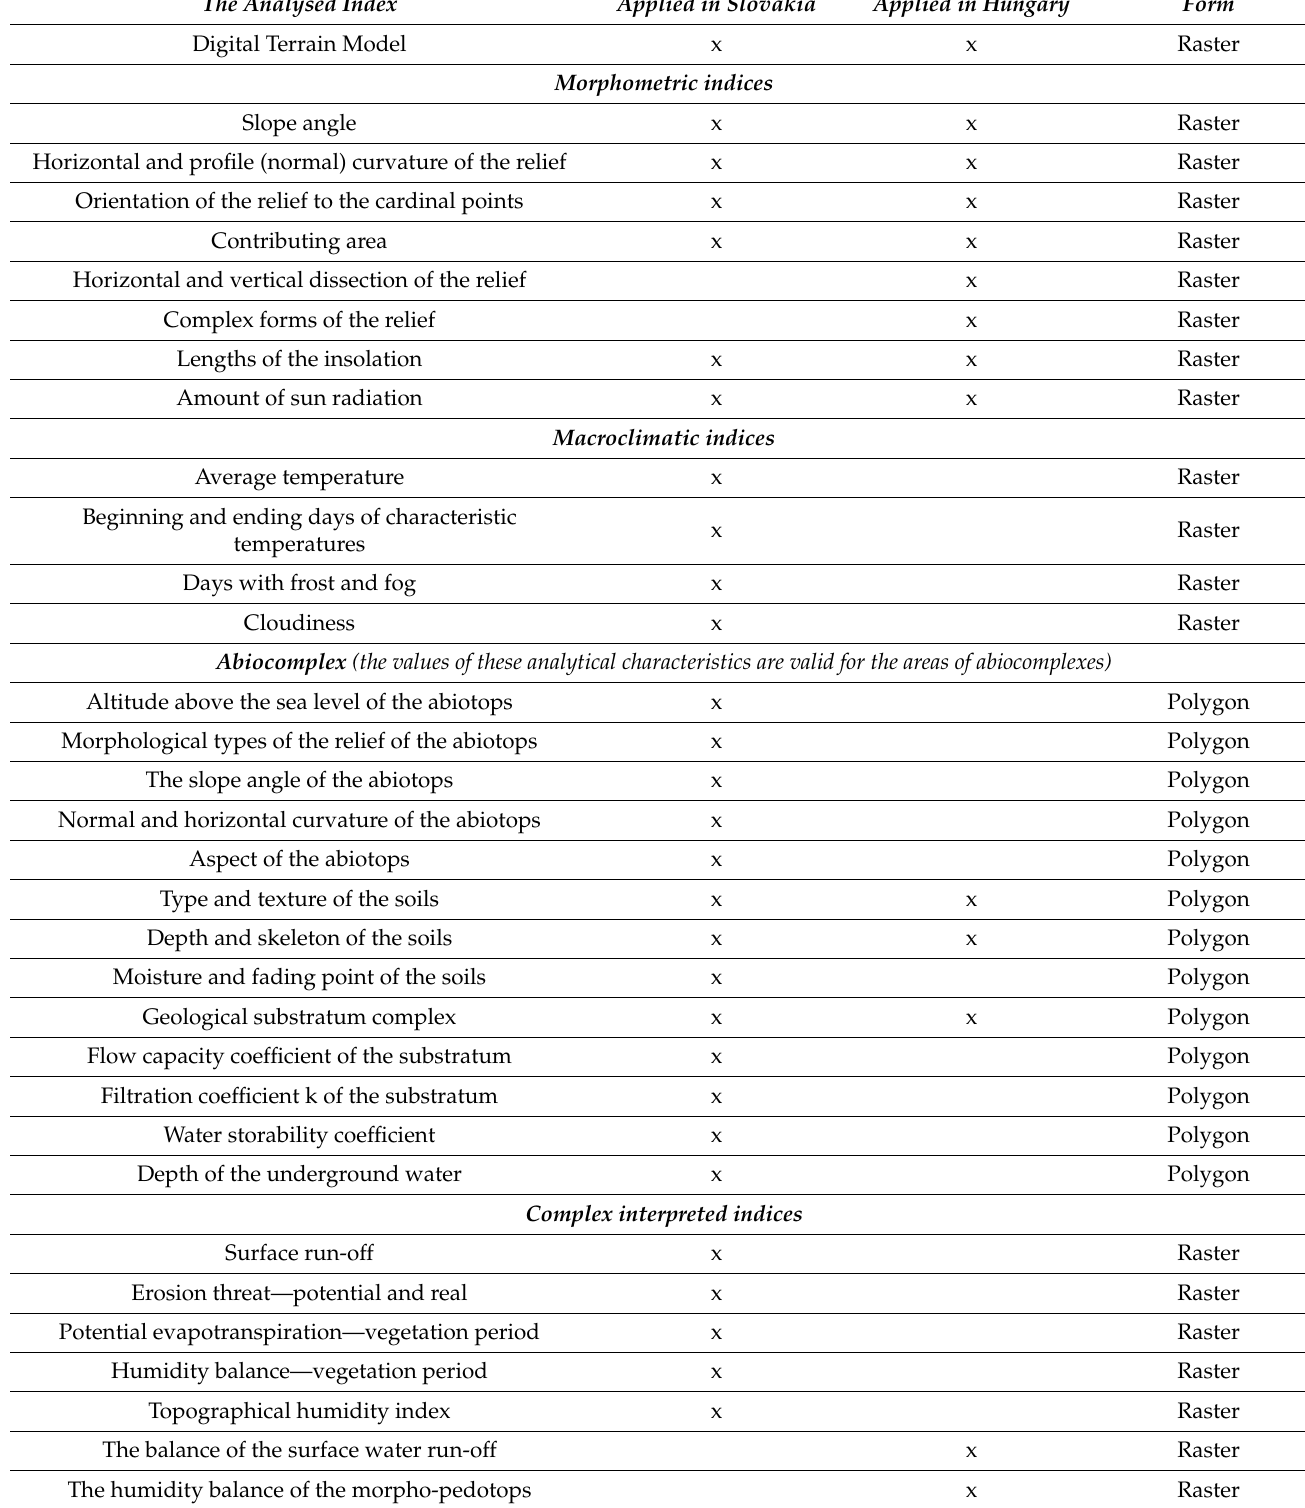
Table 1. List of analysed indices in the study areas. The indices applied to the study areas are marked with an